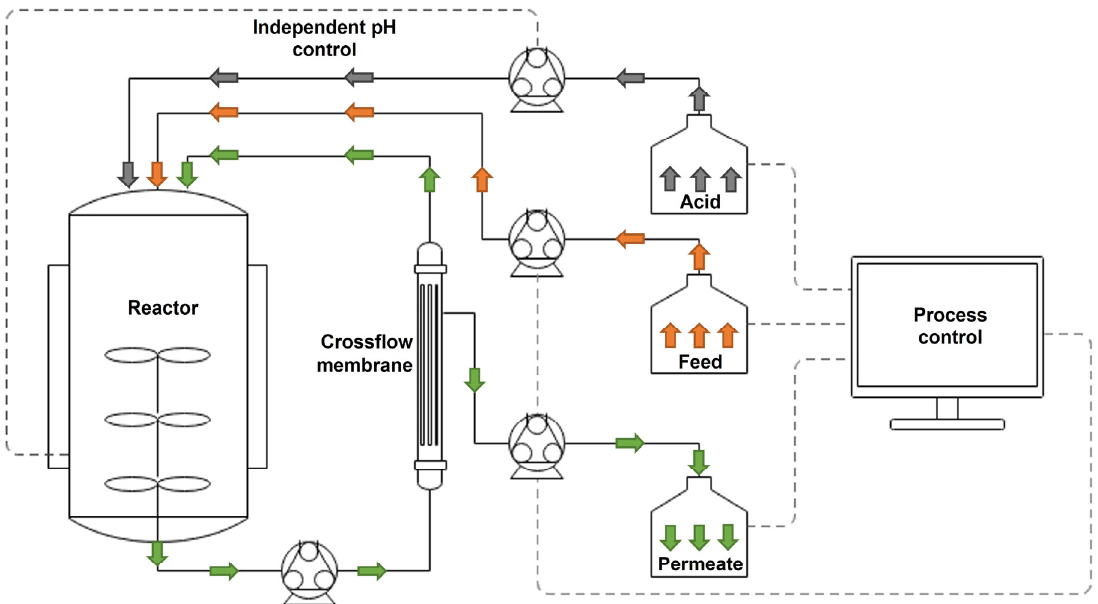
Figure 1. Schematic representation of the cell recycle system. Addition of acid (grey) and VFA feed (orange) and removal of permeate (green) via pumps is recorded by scales and controlled by the process control system in order to keep process values stable and maintain a constant volume in the